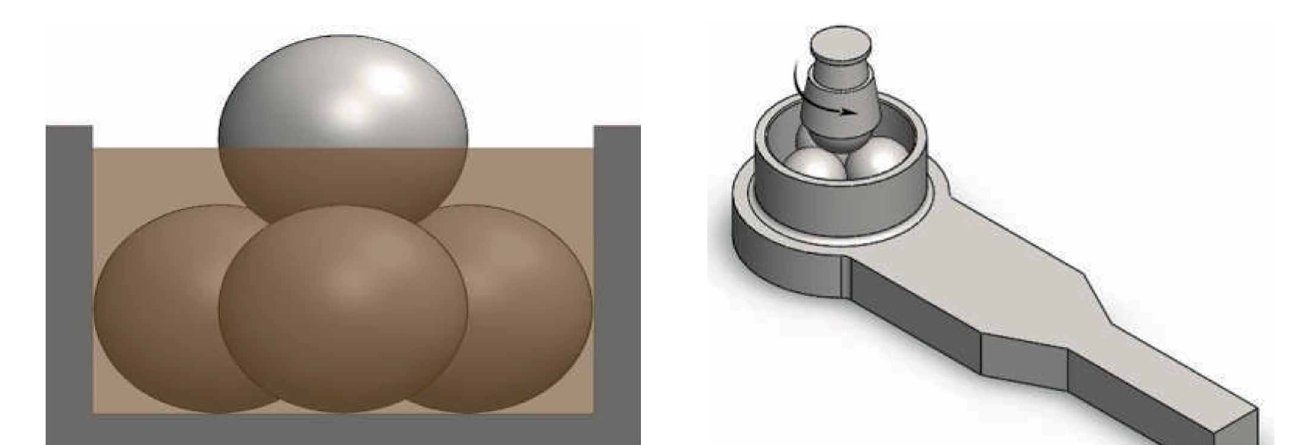
Figure 4: Schematic diagram of the four-ball tester.